Question: Write a caption explaining this figure to a reader.
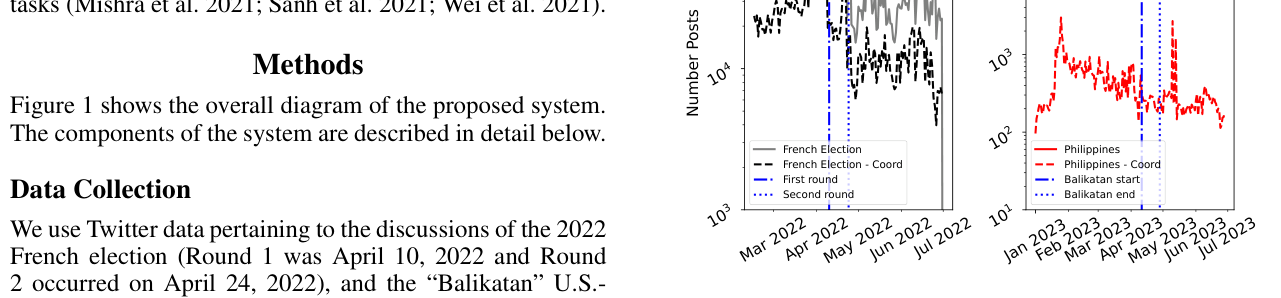
Answer: Number of posts over time from coordinated and non-coordinated accounts. (a) 2022 French election, with Round 1 and Round 2 elections labeled, and (b) 2023 Ba- likatan U.S.-Philippines military exercises that took place between April 11 and April 28, 2023.